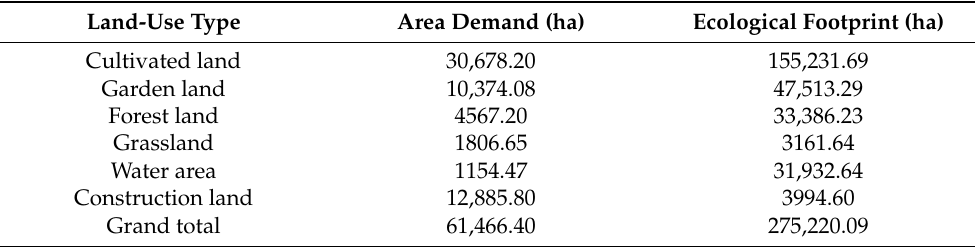
Table 10. Ecological footprint generated by socio-economic